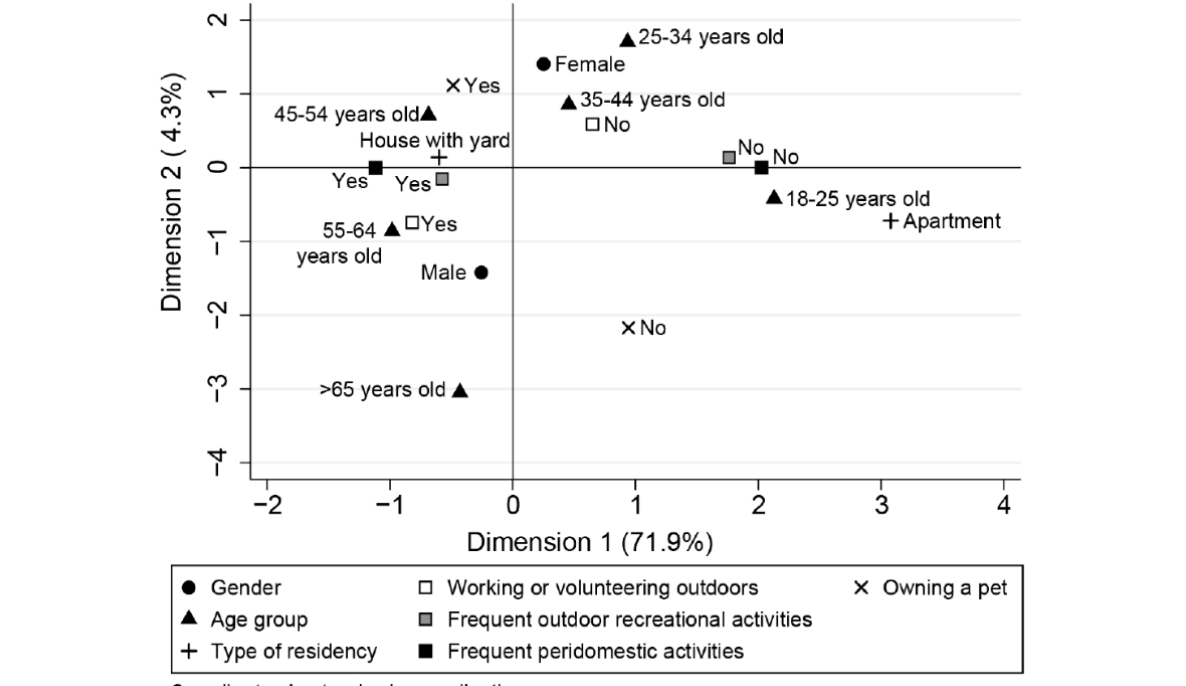
Figure 2. Biplot of the multiple correspondence analysis (MCA) of the